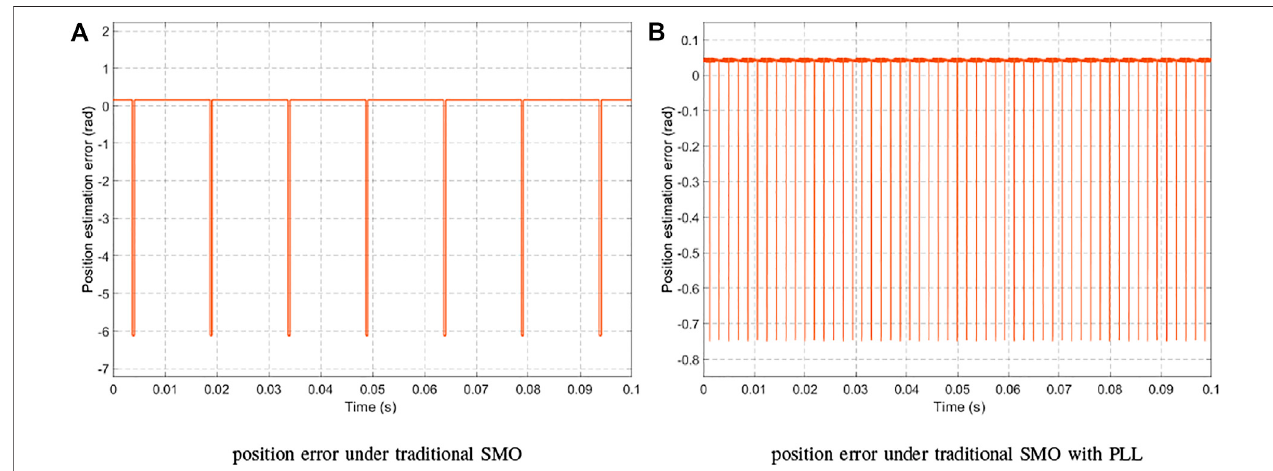
FIGURE 10 | Curve between the estimated and actual position errors. (A) Position error under traditional SMO. (B) Position error under traditional SMO with